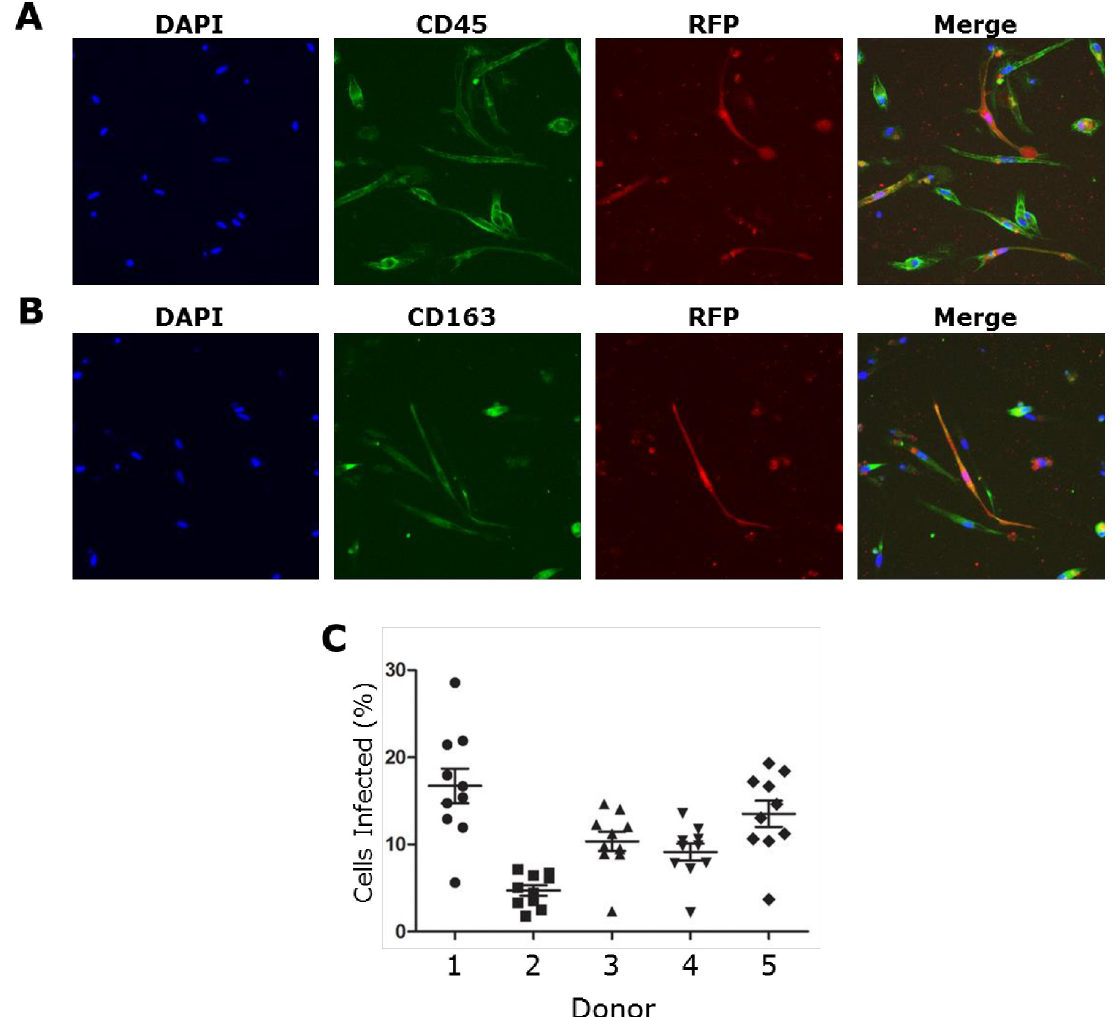
Fig 2. RSV infection of Hofbauer cells. Hofbauer cells were infected with rrRSV at MOI of 1 for 96 hours and then fixed with 4% paraformaldehyde. RFP expression by replicating rrRSV co-localized with (A) myeloid cell marker CD45 and (B) macrophage cell marker CD163 in infected Hofbauer cells. (C) Proportion of Hofbauer cells from 5 different donors exhibiting red fluorescence as a result of rrRSV replication. Infectivity was variable among donors and ranged from approximately 5 to 17 percent. Data are shown as mean ± SEM of 5 different